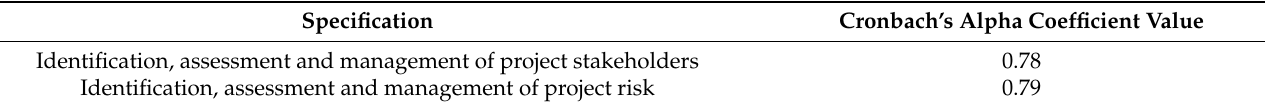
Table 2. Measuring the reliability of the expert interview questionnaire.